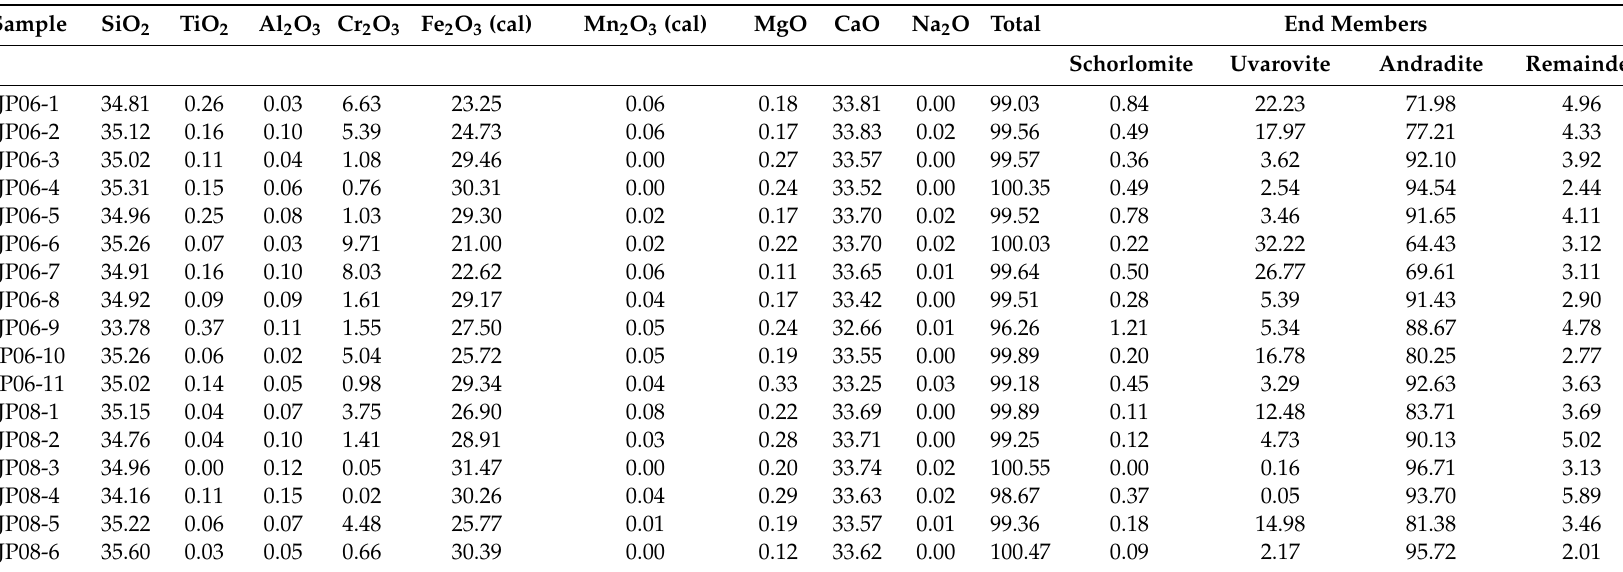
Table 6. Chemical composition of chromian andradite (in wt%) from EPMA. Values of end members were calculated on the basis of a spreadsheet after